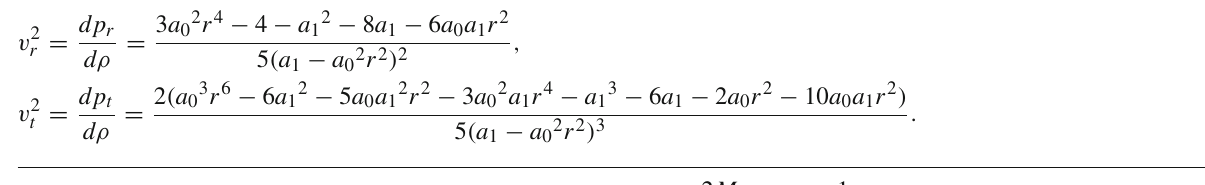
(b) Variation of density, radial and Variation of sound speed of solution Eq. (42) against radial coordinate